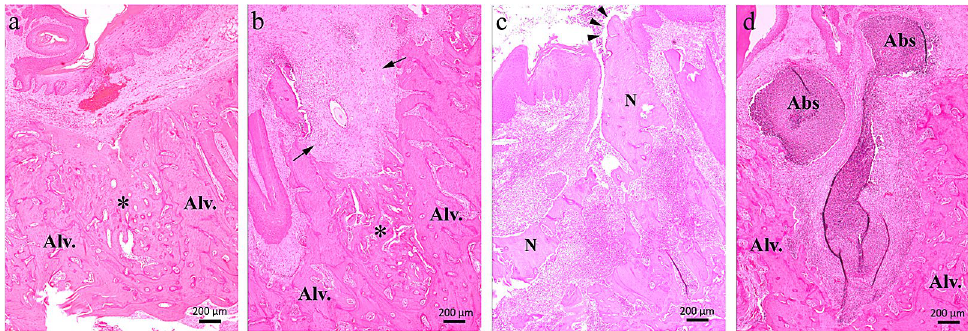
Figure 4. Representative images of ( a , b ) healing and ( c , d ) MRONJ, based on hematoxylin and eosin (H&E) staining (magnified × 50). ( a , b ) The extraction socket is filled with bone completely or partially (asterisk mark). Black arrow indicates fibrotic healing states. ( c ) The extraction socket shows impaired healing with ulcerative epithelium (arrowhead) and necrotic bone (N). ( d ) The extraction socket is filled with inflammatory cells, although surrounding bone is intact. The scale bar (black line) indicates 200 μm. Alv. alveolar bone, N necrotic bone, Abs